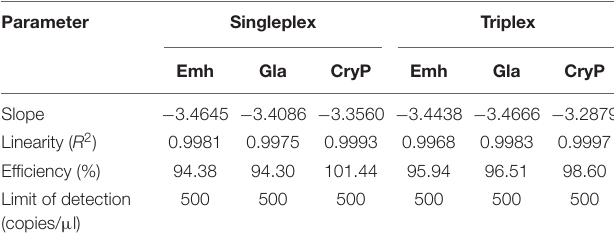
TABLE 2 | Parameters of the standard curves of the singleplex and triplex Quantitative PCR (qPCR) assays. Parameter Singleplex